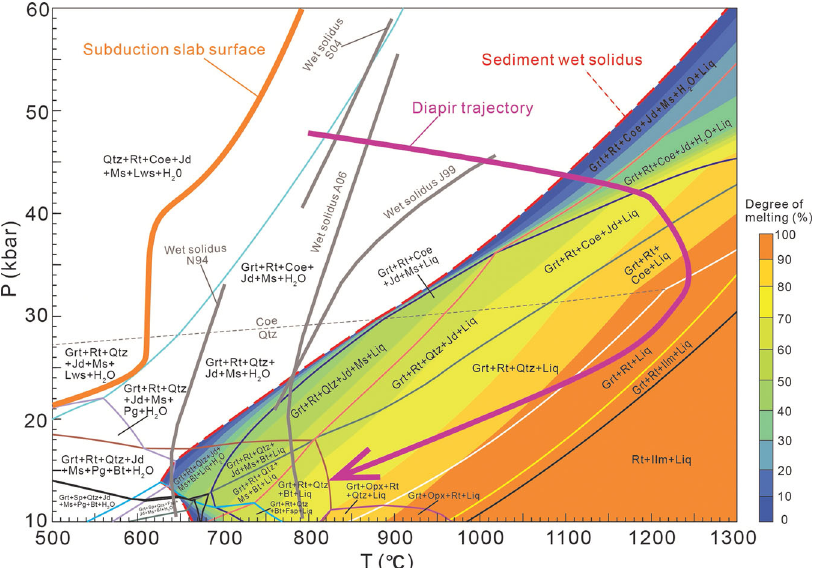
Fig. 7 P-T diagram showing the phase relations of the subducted Nicobar Fan sediments and possible diapir trajectory of the sediments. P-T conditions of the slab surface is from ref. 57 . The diapir trajectory is cited from ref. 60 . The gray lines represent the experimentally determined wet solidi of metapelite and metagreywacke: N94 from ref. 10 , J99 from ref. 59 , S04 from ref. 58 , and A06 from ref. 94 . The P-T pseudosections are shaded with a warmer color tone as the partial melting degrees increase. Bt-Biotite, Coe-Coesite, Grt-Garnet, Fsp-Feldspar, Ilm-Ilmenite, Jd-Jadeite, Liq-Liquid, Lws-Lawsonite, Ms- Muscovite, Opx-Orthopyroxene, Pg-Paragonite, Qtz-Quartz, Rt-Rutile, Sp-Sphene.